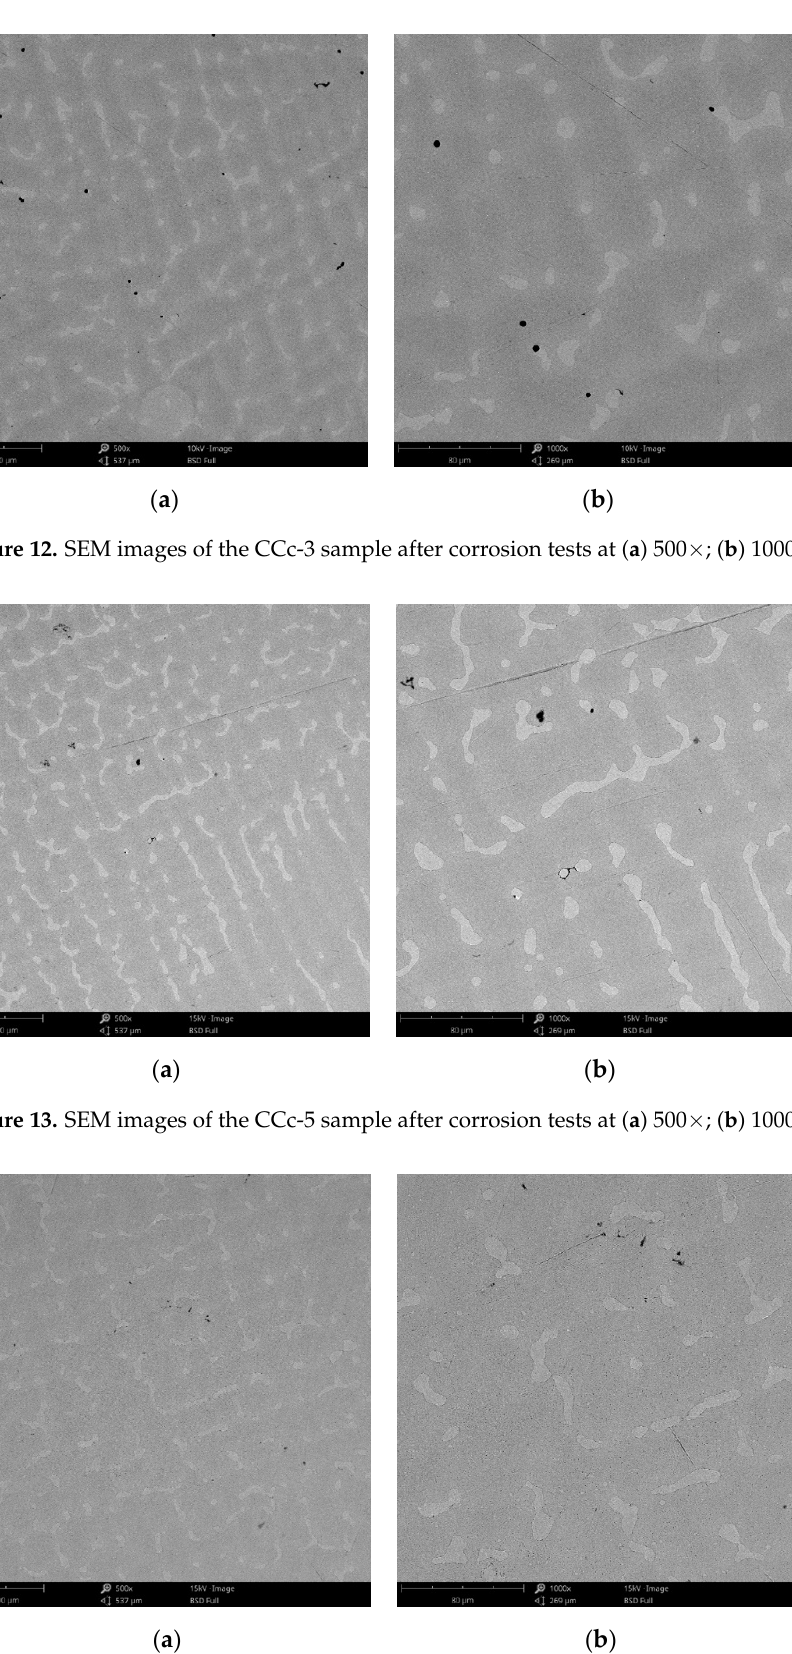
( a ) ( b ) Figure 15. SEM images of the CCm-3 sample after corrosion tests at ( a ) 500×; ( b ) 1000×. ( a ) ( b ) Figure 16. SEM images of the CCm-5 sample after corrosion tests at ( a ) 500×; ( b ) 1000×.